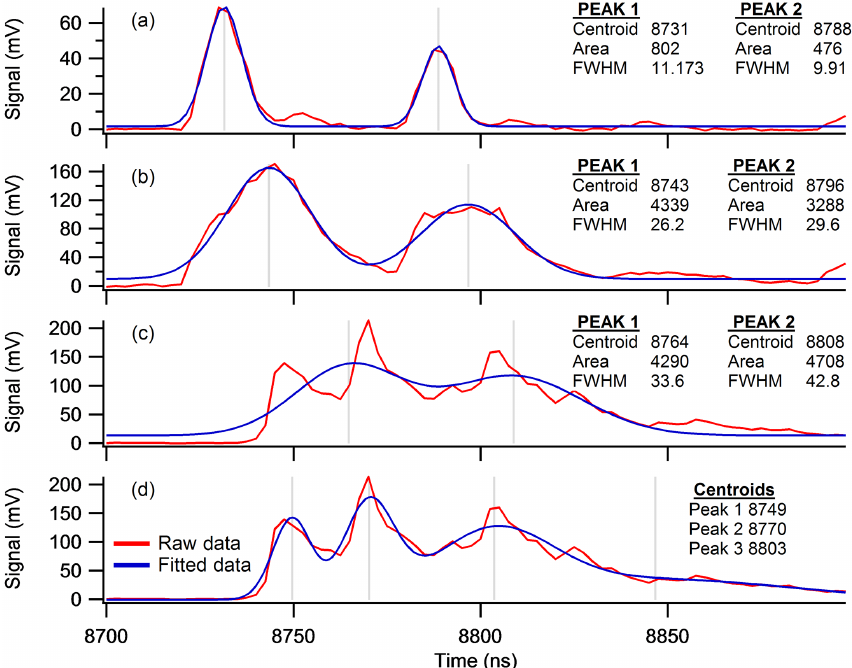
Figure 3. Peak fitting of the SiO − molecular ion ( m/z − 76) and its neighbour at m/z − 77. (a) Well-resolved Gaussian peaks with a peak 3 centroid spacing of 50ns, (b) peak broadening observed in illite-rich material, (c) multimodal peaks resolved into two peaks with approxi- mately 50ns spacing and (d) the same multimodal peak resolved into peaks with centroid spacing < 50ns by reducing the number of times data was smoothed to 2. Fitting parameters used were number of smoothes 5, Min fraction was 0.1 unless stated